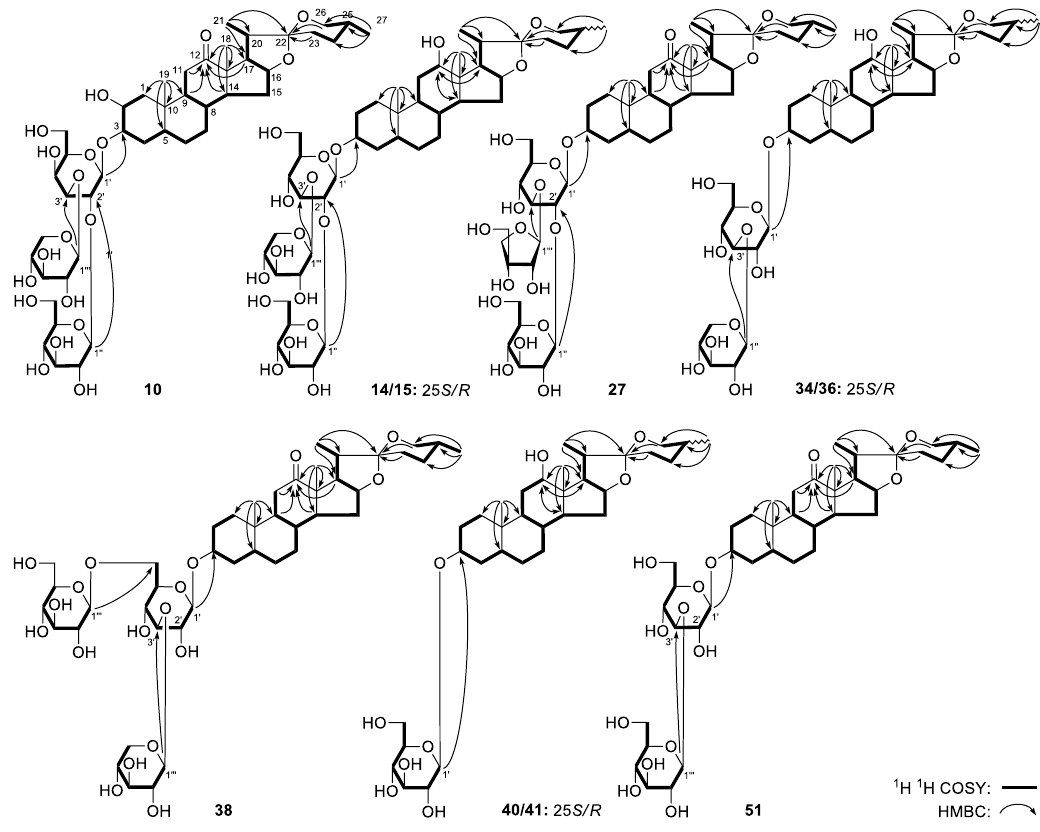
Figure 4. The main 1 H 1 H COSY and HMBC correlations of 10 , 14 / 15 , 27 , 34 / 36 , 38 , 40 / 41 , 51. 25( S/R )- 5β -spirostan- 3β,12β -diol 3- O- β - D -xylopyranosyl(1 → 3)- [β - D -glucopyranosyl(1 → 2)] - β - D -glucopyranoside ( 14/15 ), 25( S/R )- 5β -spirostan- 3β,12β -diol 3- O - β - D -xylopyranosyl(1 → 3)- β - D -gluco-pyranoside ( 34/36 ) and 25( S/R )- 5β -spirostan- 3β,12β -diol